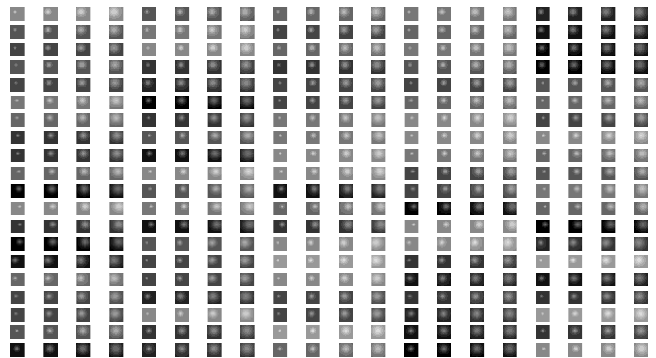
Figure 2. Gaussian over-complete dictionary.